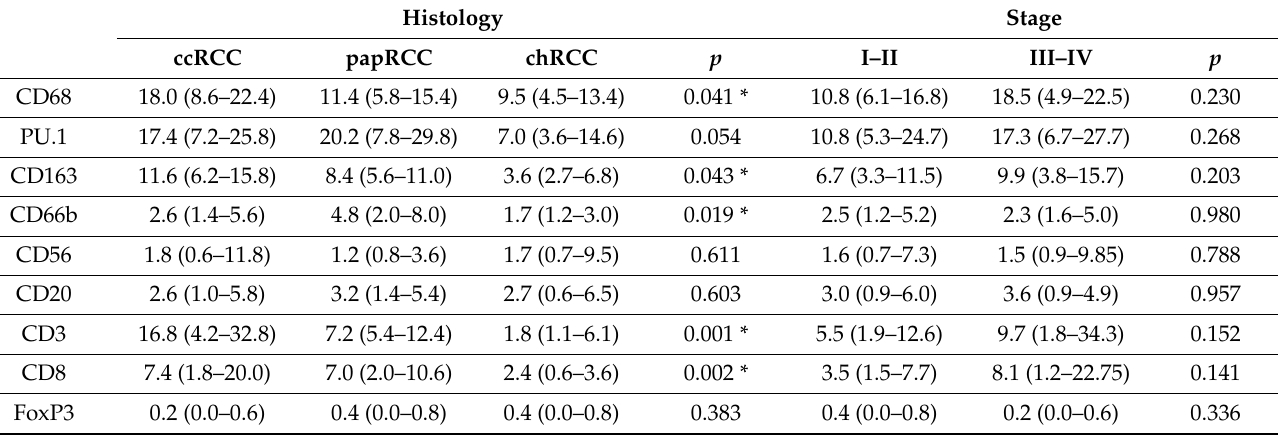
Table 4. Association of the content of CD68, PU.1, CD163, CD66b, CD56, CD20, CD3, CD8, FoxP3 positive cells in the stroma with the histological type of tumor and stage of the disease (median